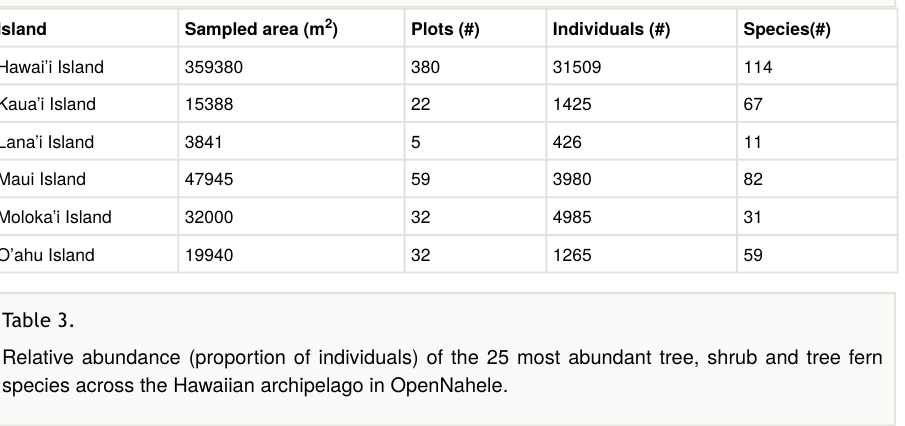
Sampled area, number of plots and number of individuals and species per island in OpenNahele.